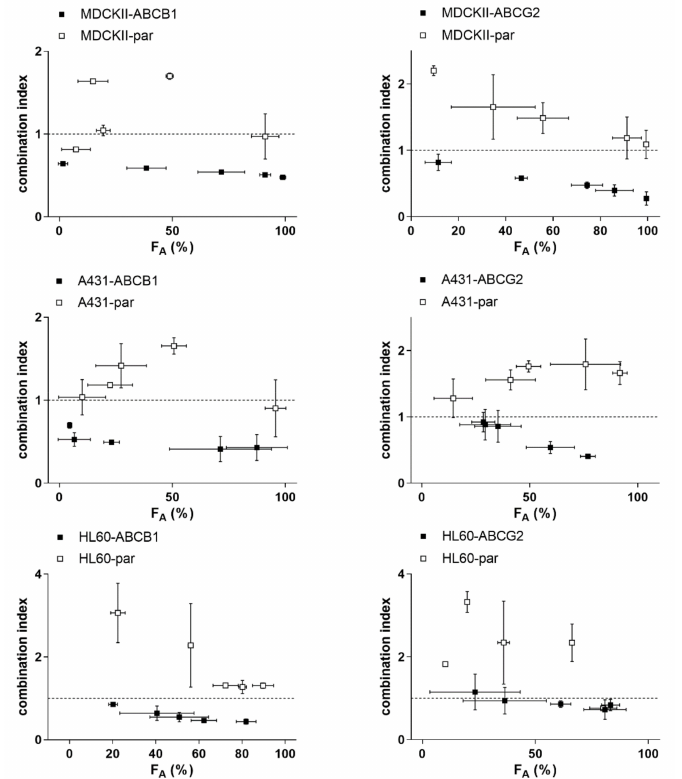
Figure 4. Combination index (CI) analysis of the drug combinations shown in Figure 3. Combination outcomes can be synergistic (CI < 0.9), additive (0.9 < CI < 1.1), or antagonistic (CI > 1.1). F A , the fraction of cells